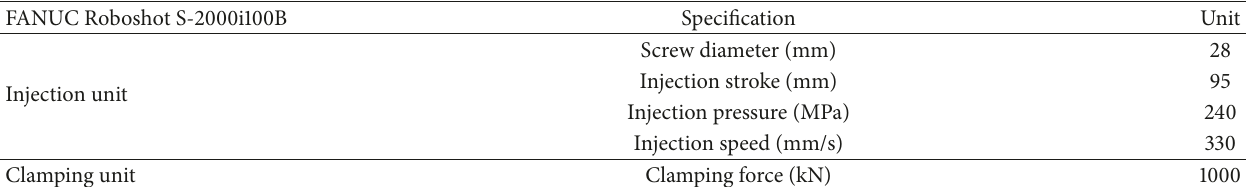
Table 4: Machine